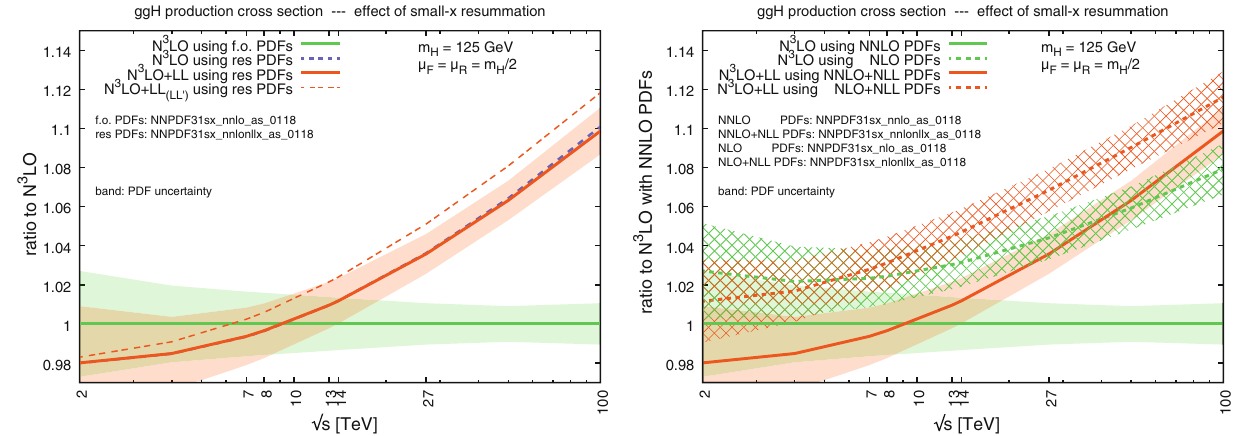
Fig. 5 Ratio of the N 3 LO Higgs cross section with and without resummation to the N 3 LO fixed-order cross section, as a function of the collider center-of-mass energy. The PDFs used are from the global dataset of Ref.